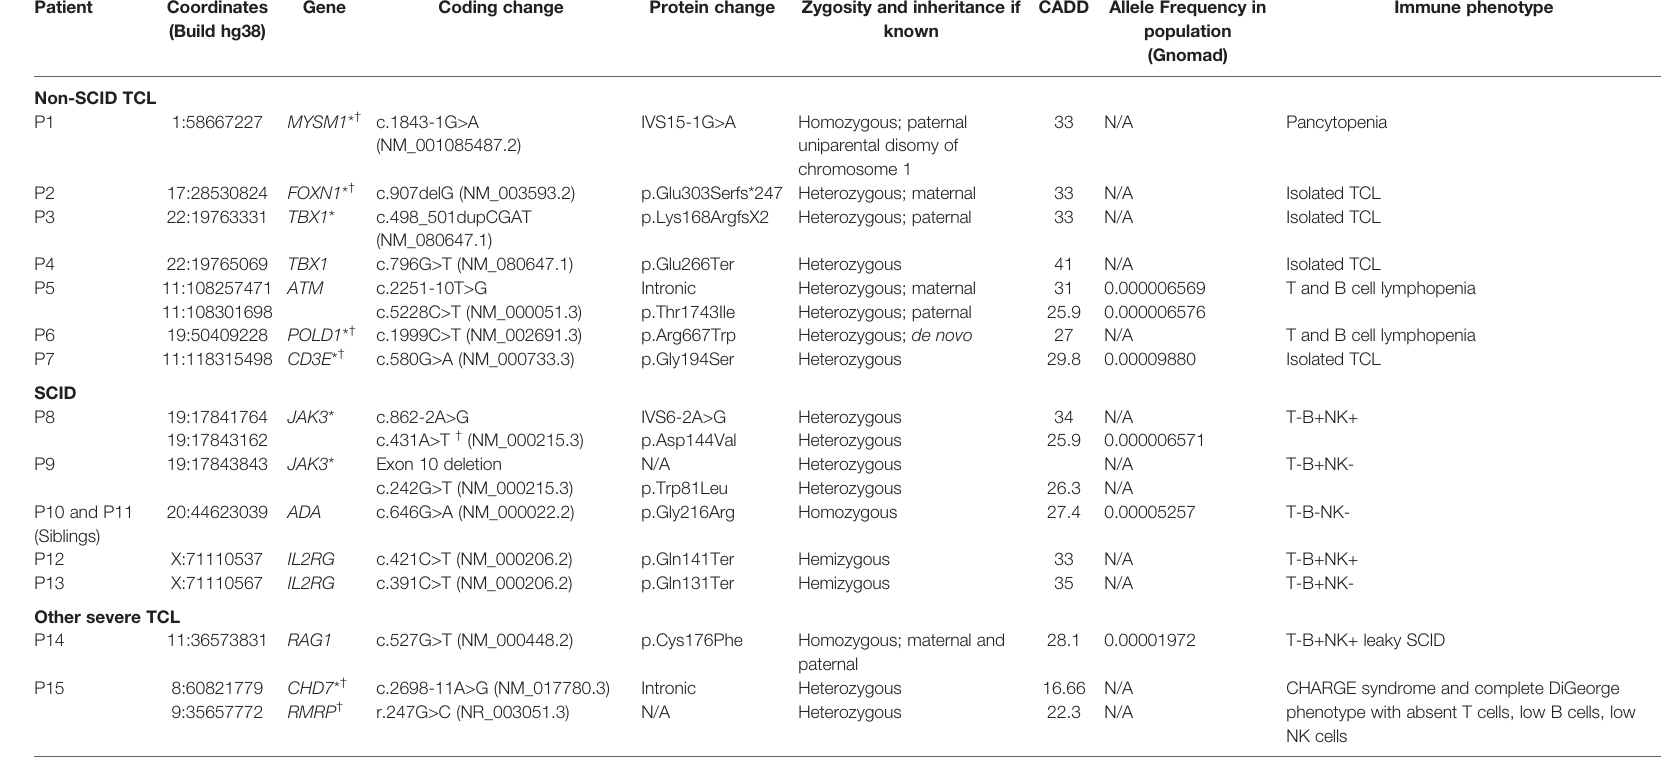
*Novel variant at time of diagnosis. † Variant of uncertain signi fi